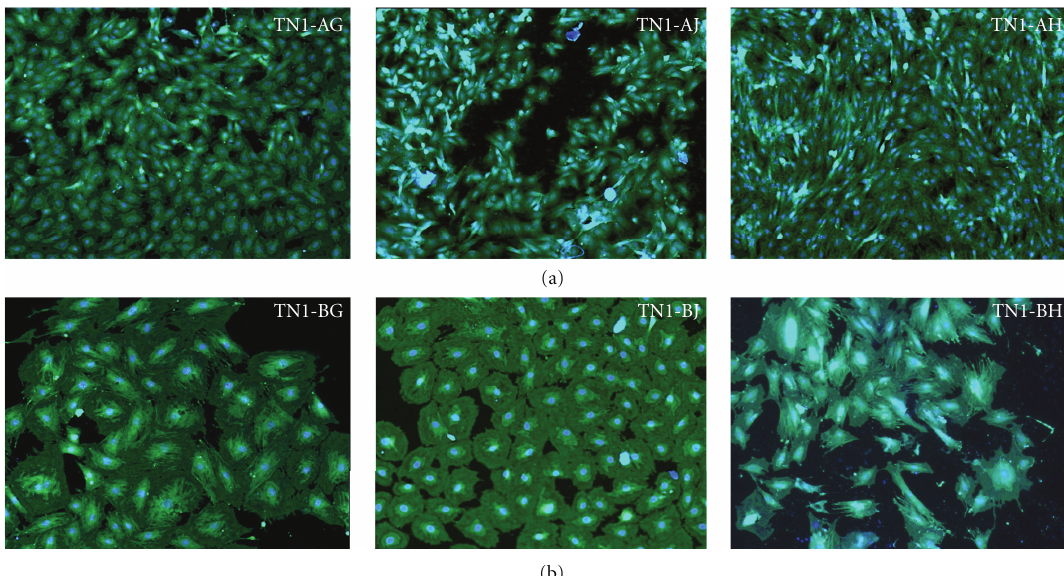
Figure 11: Images of fixed MSCs (prevailing colonies) stained with 6-carboxyfluorecein diacetate (6-CFDA) and DAPI on the NiTi specimen surfaces di ff ering in chemical composition and roughness; 14th day of cultivation; magnification is × 10; cells are green, nuclei are